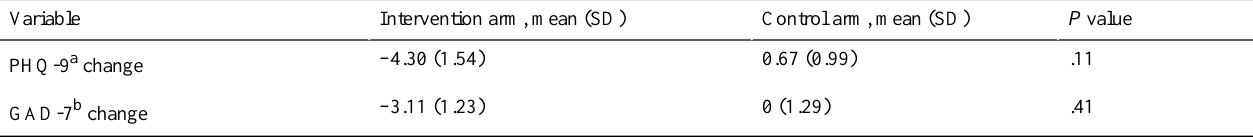
Table 5. Pre-post analysis of changes in depression and anxiety